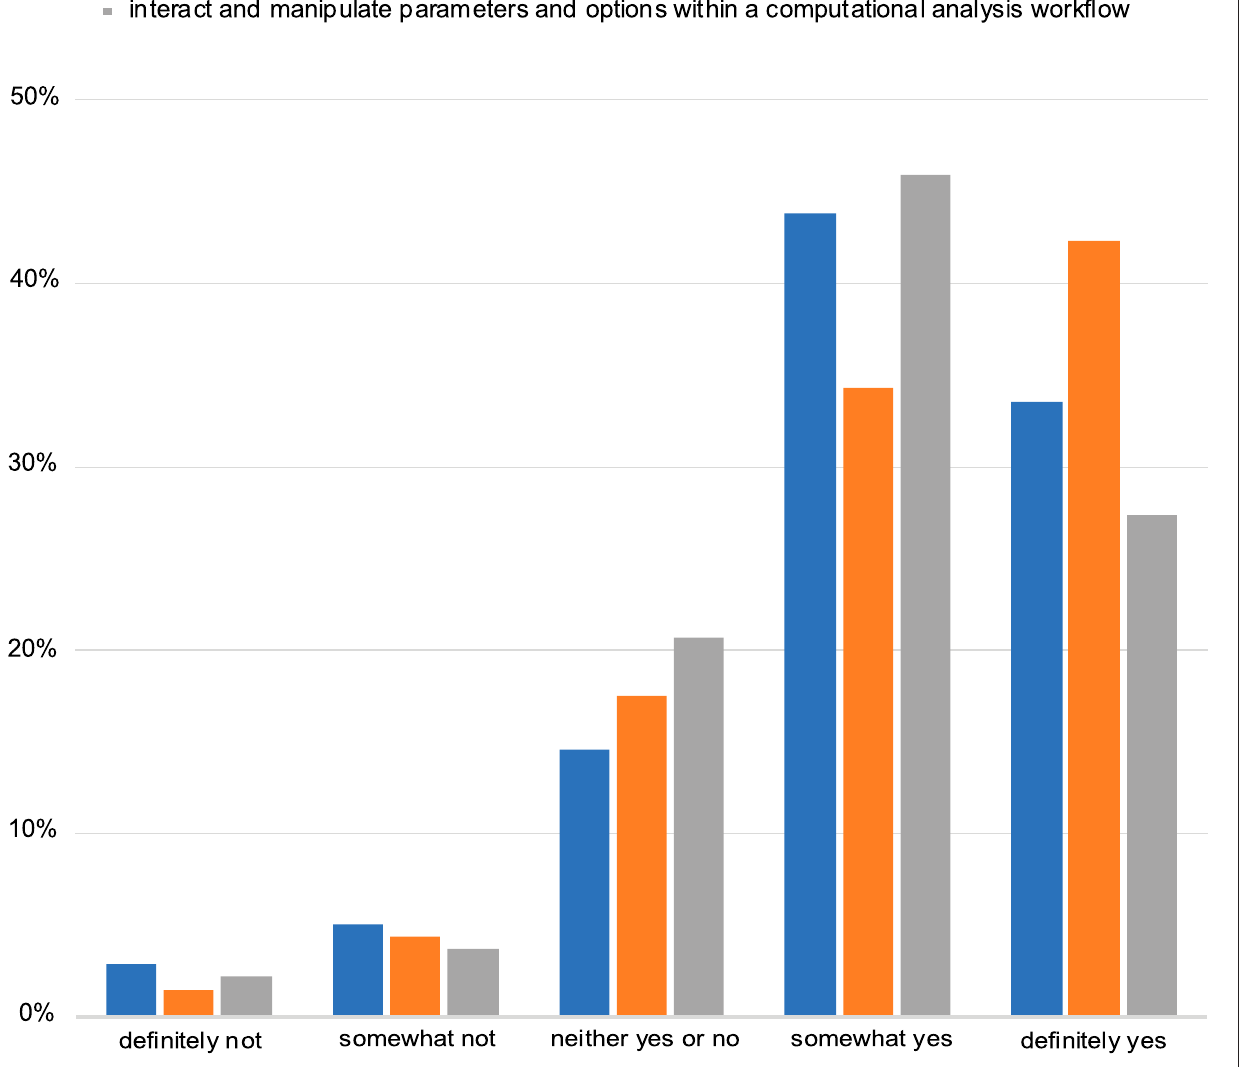
Frontiers in Research Metrics and Analytics |